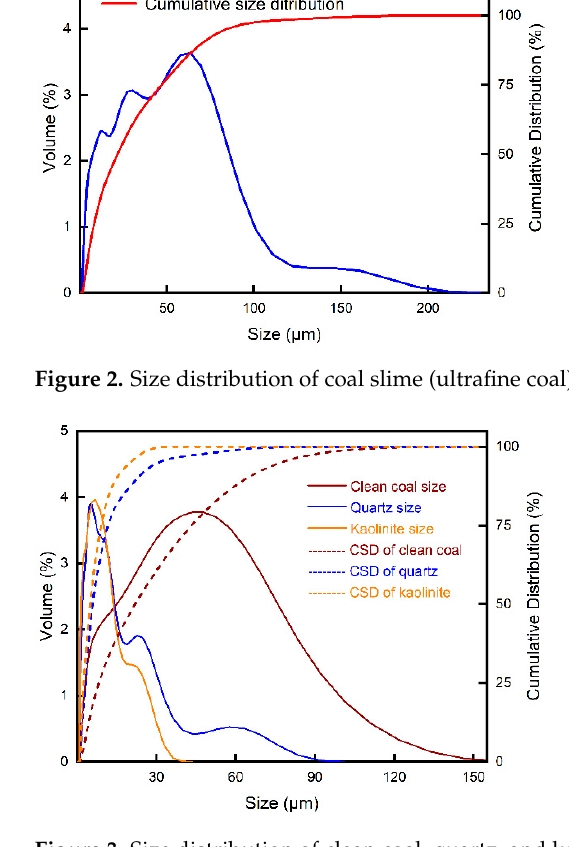
Figure 3. Size distribution of clean coal, quartz, and kaolinite.